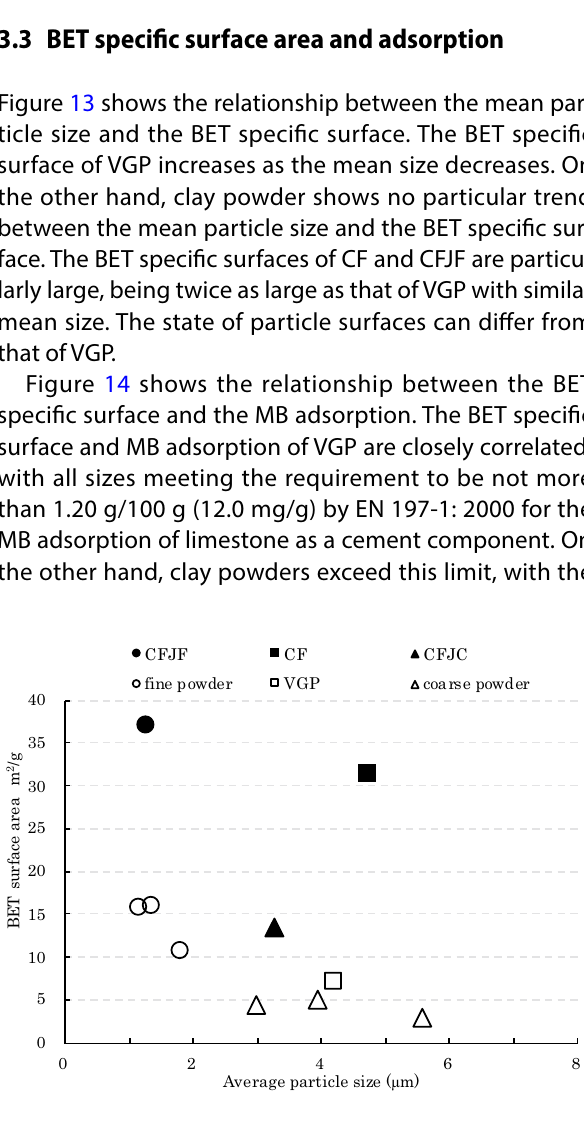
Fig. 13 Relationship between mean particle size and BET surface area of VGP and Clay